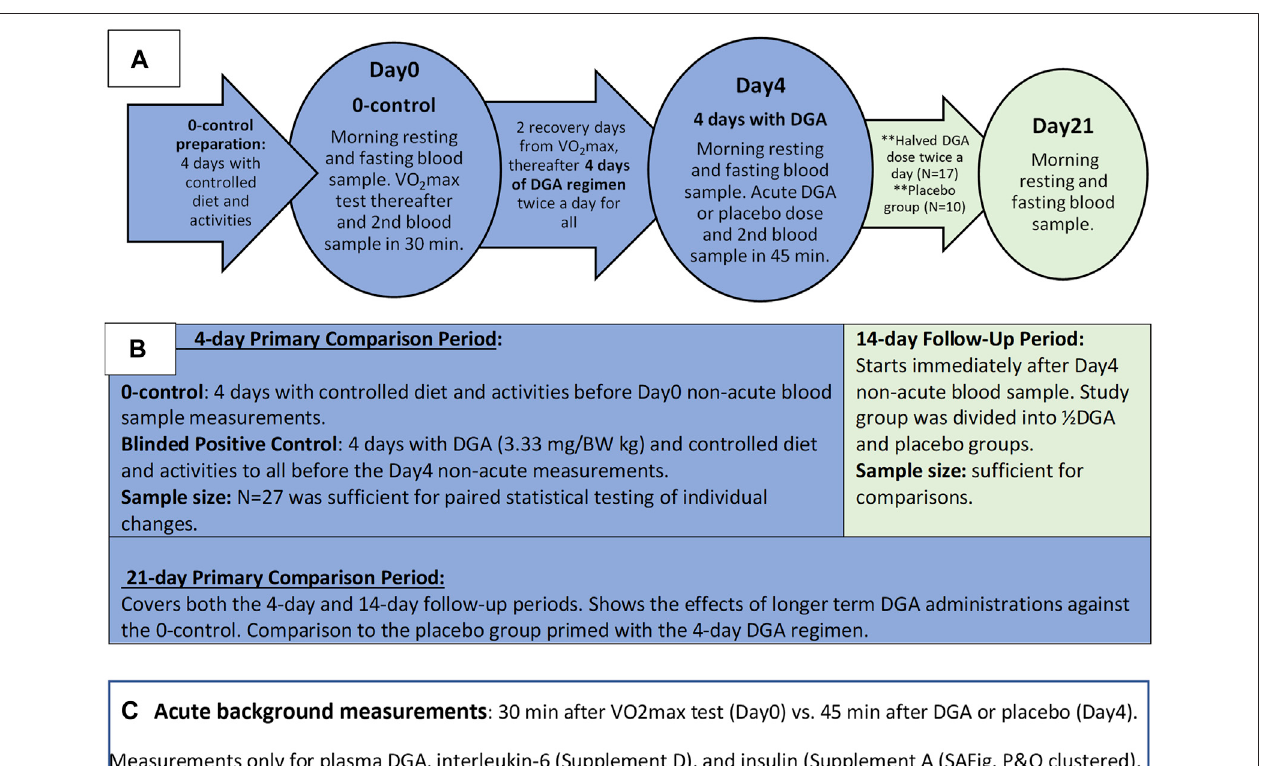
FIGURE 1 | Outline of the Study: Timelines and measurements (A) , main phases of study (B) , and the acute measurements (C) .